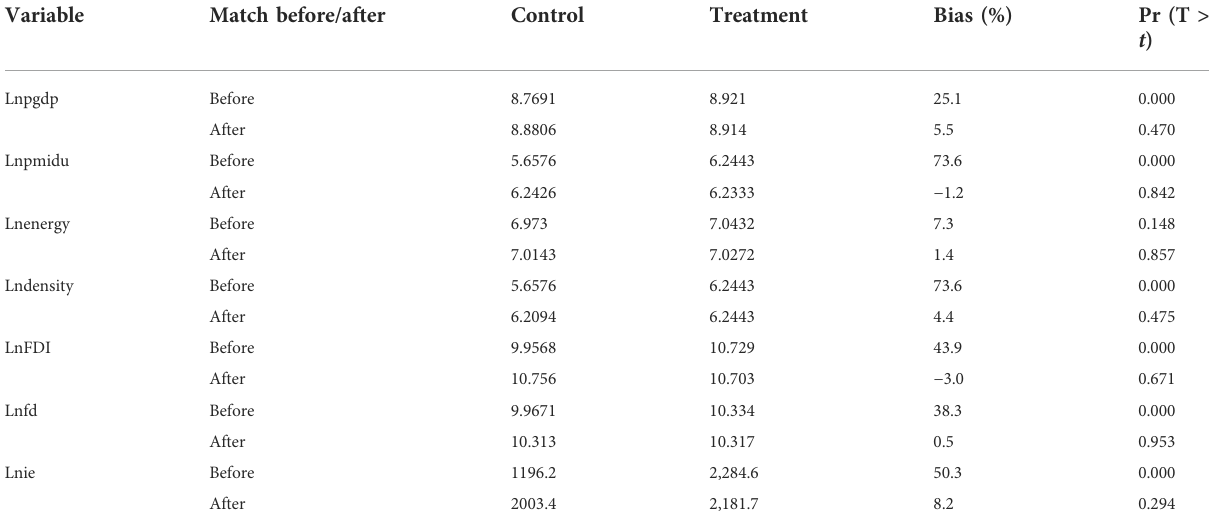
TABLE 6 Propensity score matching balance test.